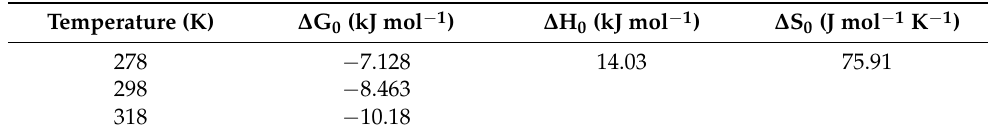
Table 4. Adsorption thermodynamic